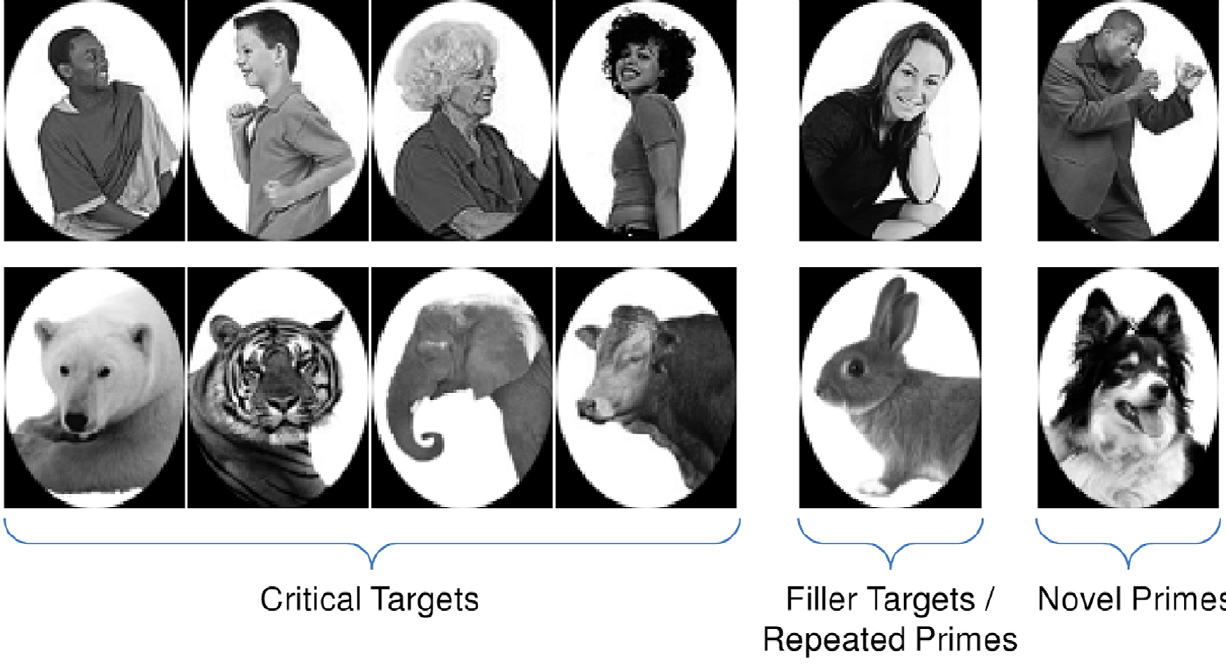
Figure 1. Stimuli used in Experiment 1.